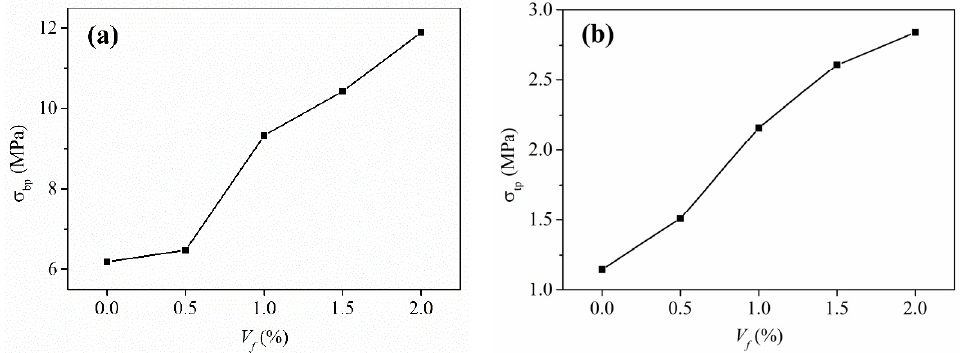
Figure 17. Effect of fiber volume fraction: ( a ) bending peak stress and ( b ) tensile peak stress.